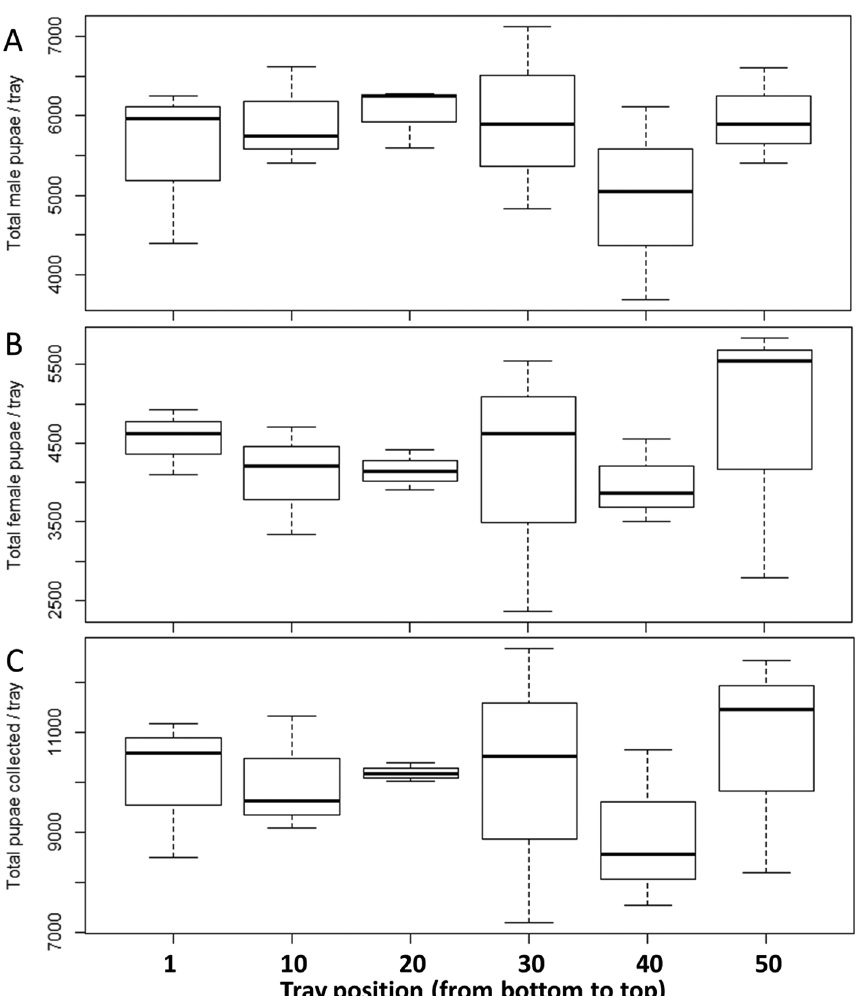
Figure 4. Number of (A) male pupae, (B) female pupae, and (C) total pupae as a function of the position of the rearing tray inside the rack in Aedes aegypti. No signi fi cant variation in the number of pupae collected as a function of tray position within the rack. Data presented in the fi gure are expressed as mean ±